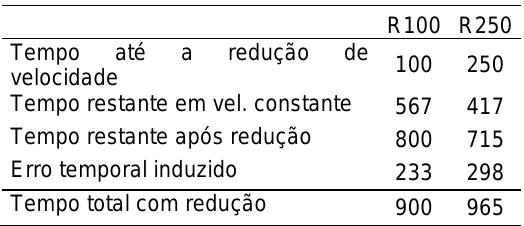
Tabela 1. Parâmetros Temporais Envolvidos